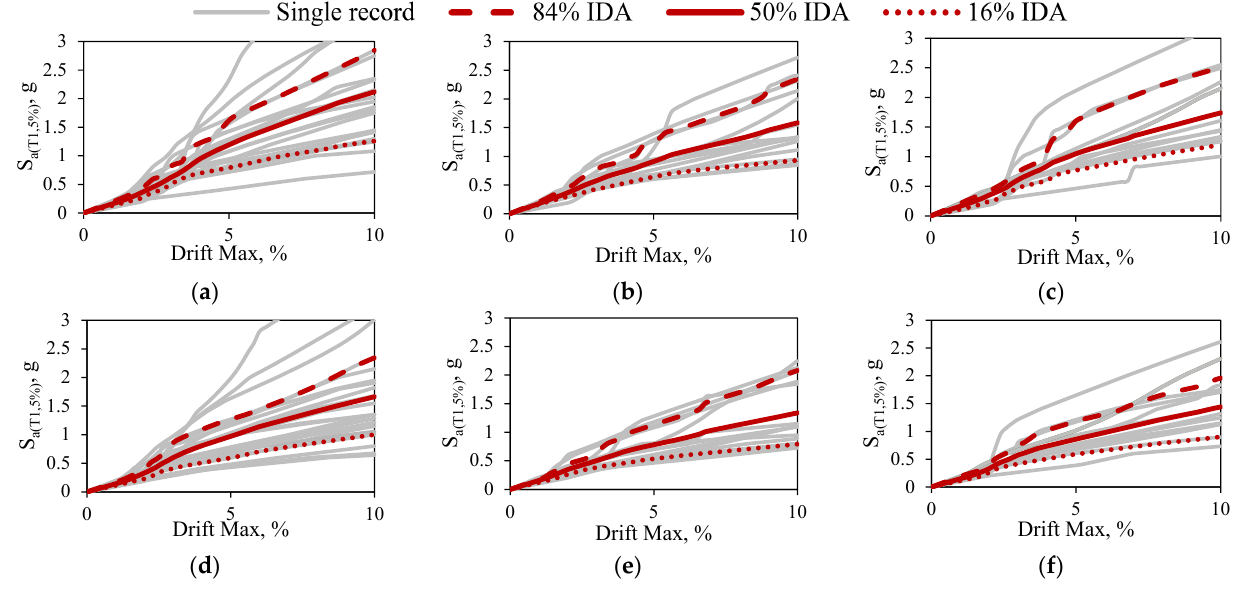
Figure 7. The 16%, 50%, and 84% fractile IDAs for 6-story initial and MRF06-1to6-1000a scenario models subjected to ( a , d ) FF, ( b , e ) NF-No Pulse, and ( c , f ) NF-Pulse records, respectively.